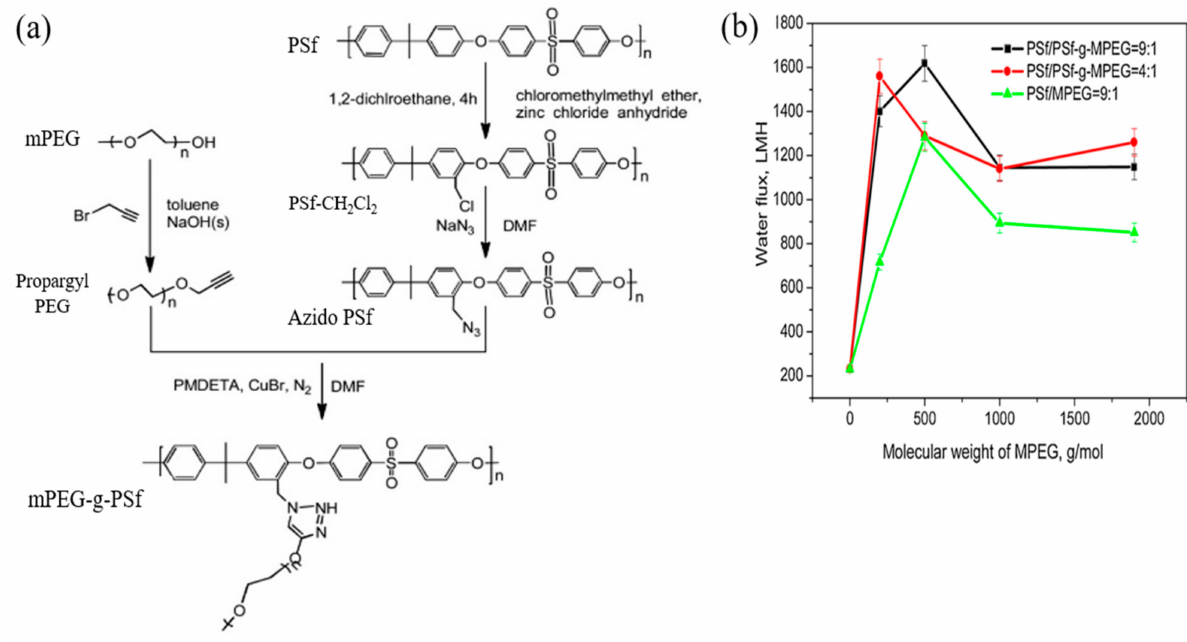
Figure 8. ( a ) Schematic representation of the preparation of alkynyl- methoxypolyethylene glycol (mPEG), chlorinated PSU, azido-PSU and the click reaction between alkynyl-mPEG and azido-PSU to obtain mPEG-g-PSU; and ( b ) the water flux test for the substrate membrane [135].